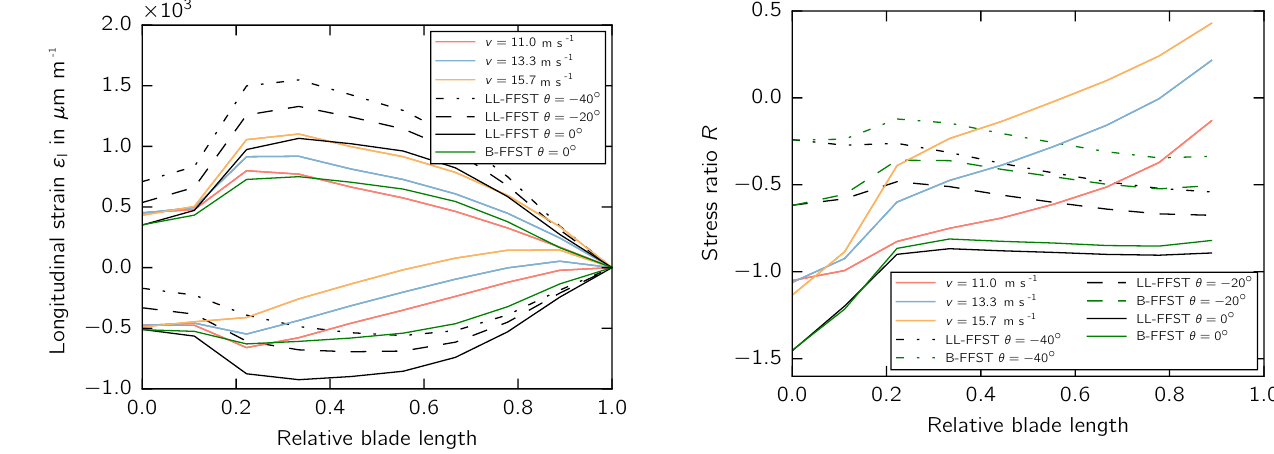
Figure 7. Axial strain along the trailing-edge bond line at different wind speed bins, lead–lag (LL-FFST) and bi-axial (B-FFST) fatigue full-scale blade tests at different pitch angles.